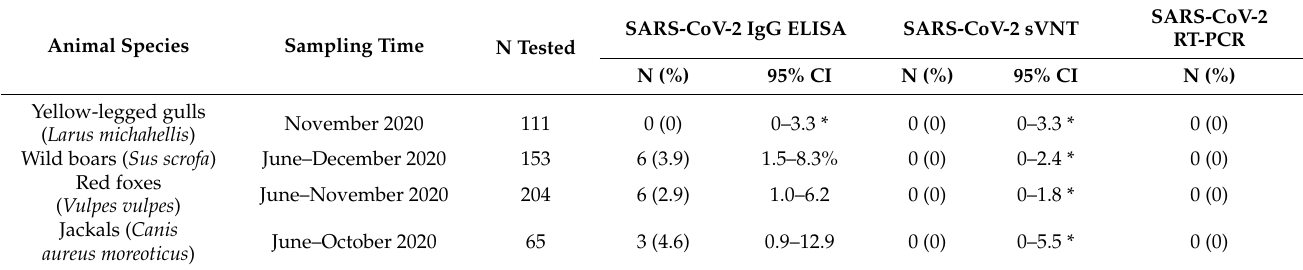
Table 4. Seroprevalence of SARS-CoV-2 in free-living wild